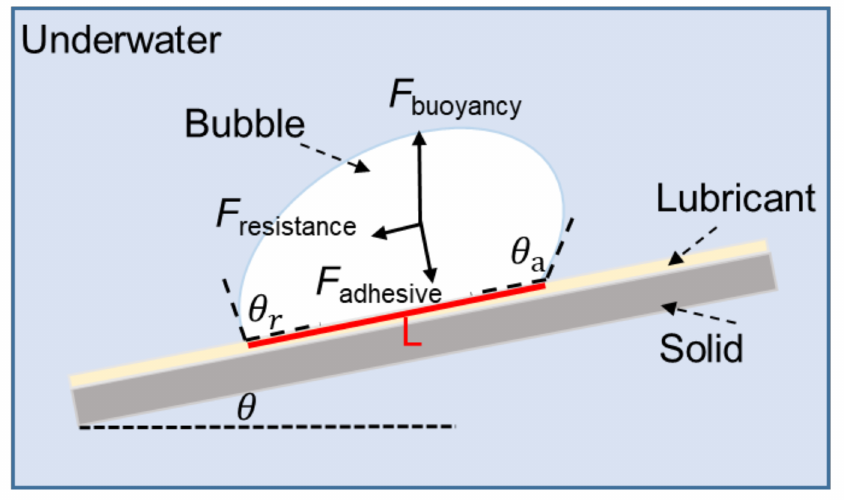
Figure 4. The mechanical analysis of the underwater bubble when it slips along the inclined LIAMSS. It is shown that the mechanism of underwater bubble sliding on the inclined slippery surface is related to the competition between the driving force induced by the underwater buoyancy and the resistance force induced by the contact angle